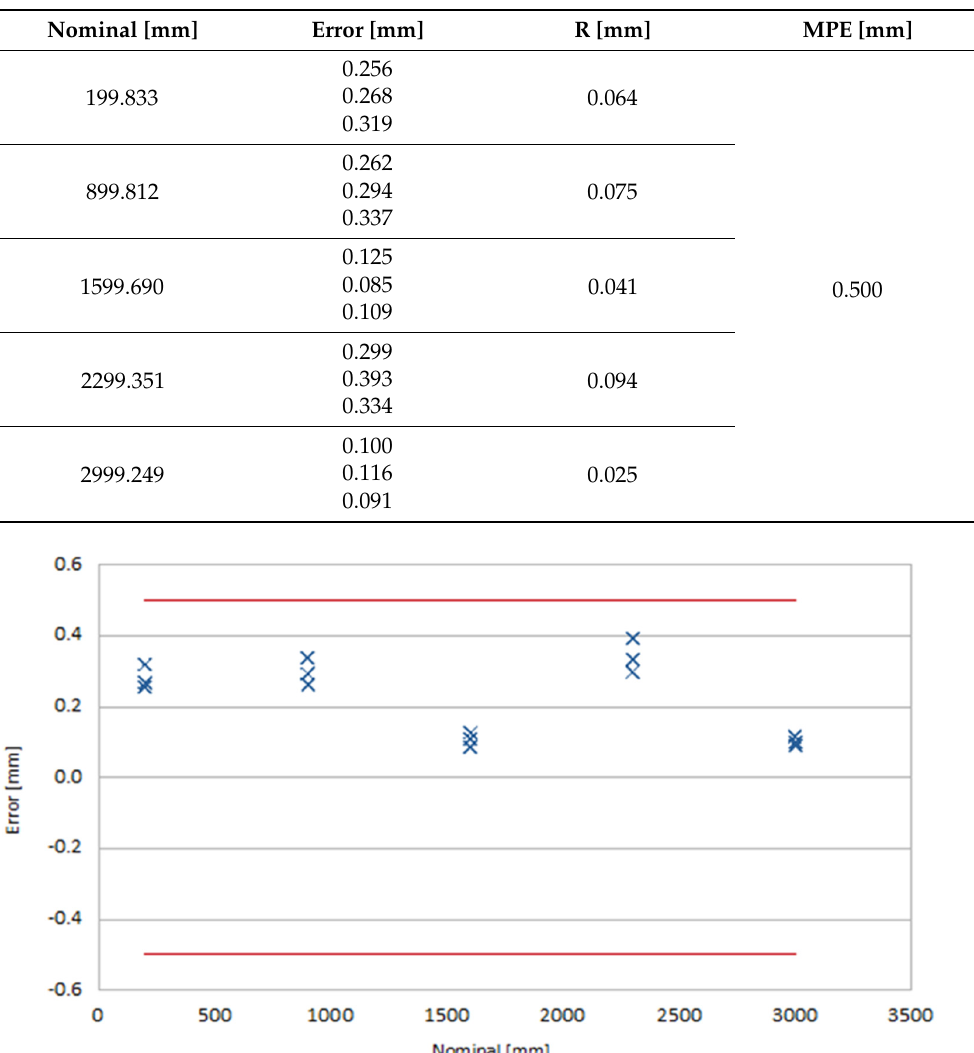
Figure 8. Z − axis measurement error characteristic. Table 4. Measurement errors of the XZ1 axis.